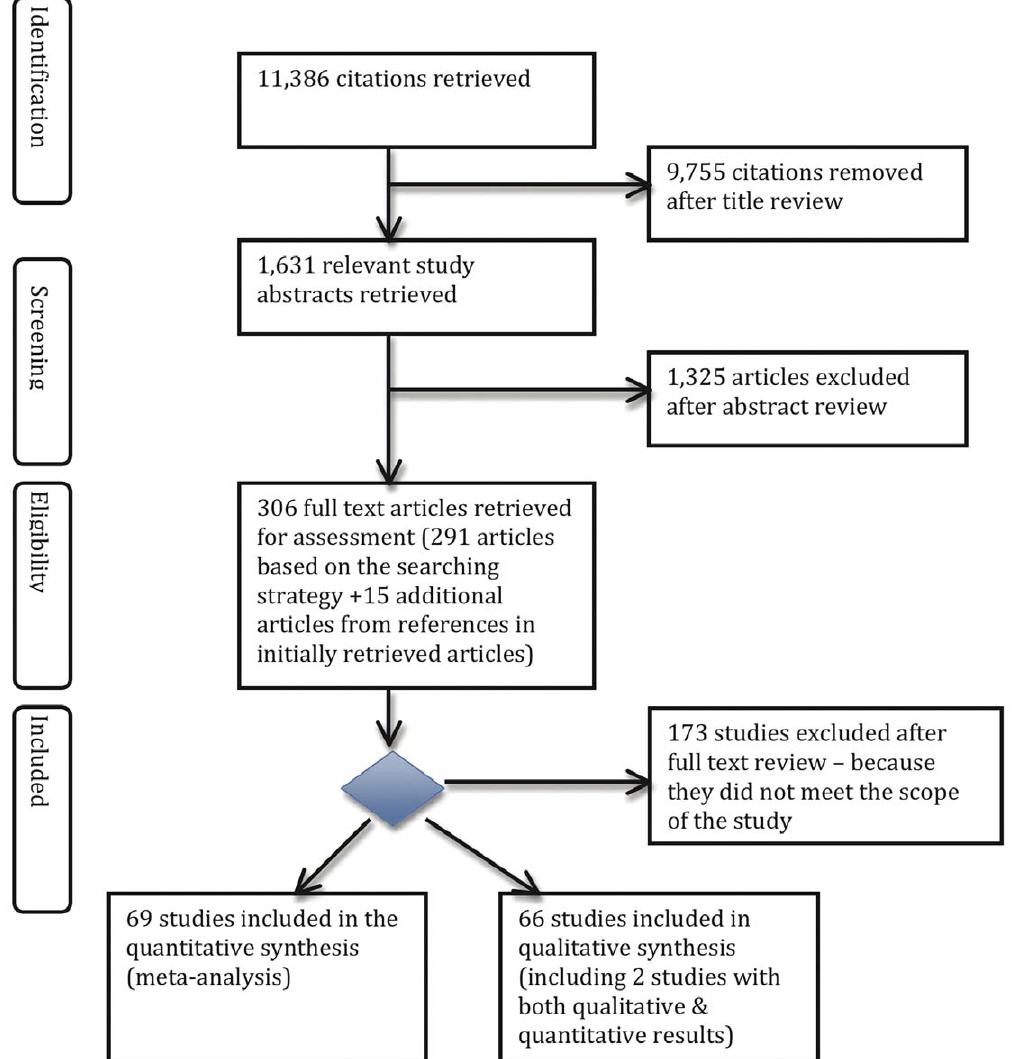
Figure 1. Flow chart of review process.